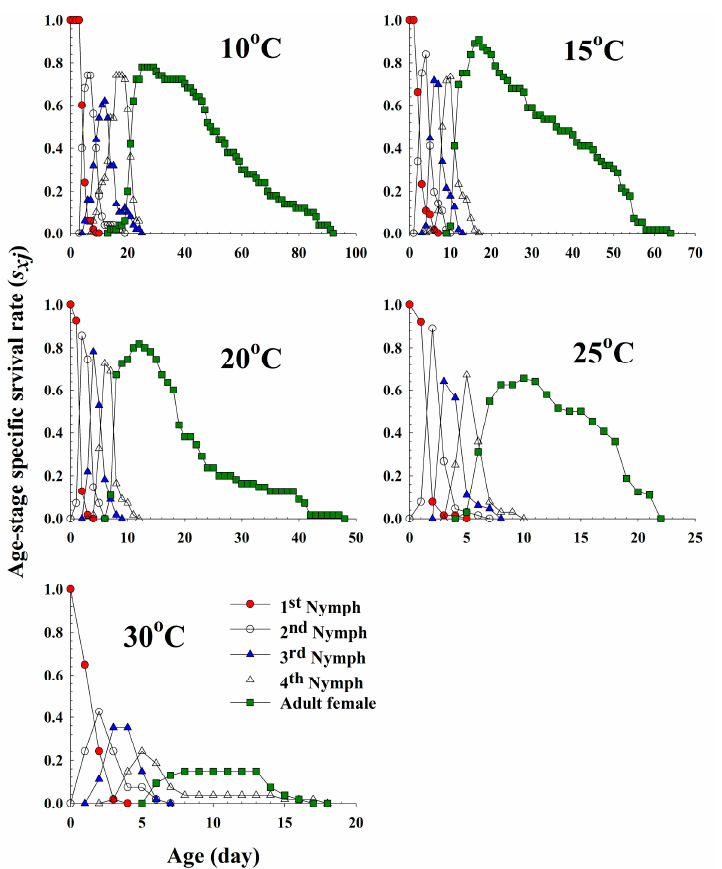
Figure 1. The age-stage-specific survival rate (s xj ) of Acyrthosiphon pisum in response to different temperature conditions.